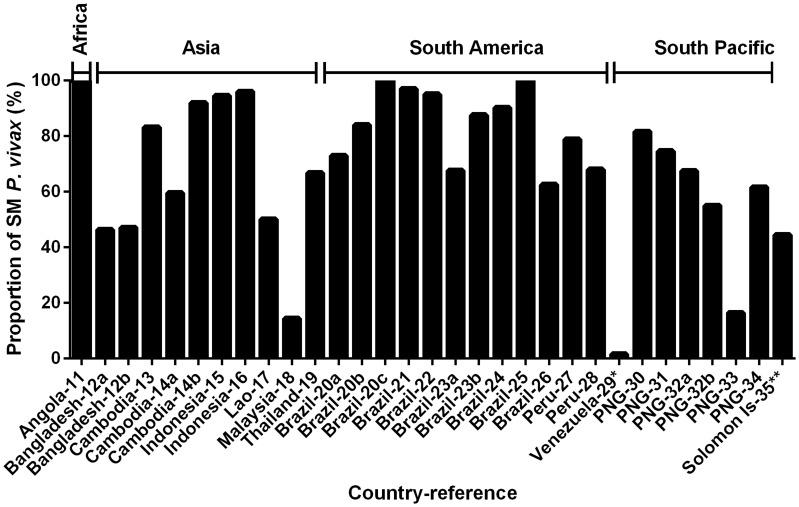
Relative proportion of SM (sub-microscopy) P. vivax in cross-sectional surveys.Countries where data were collected and their corresponding references (detailed in Table 1) are shown on the x-axis.